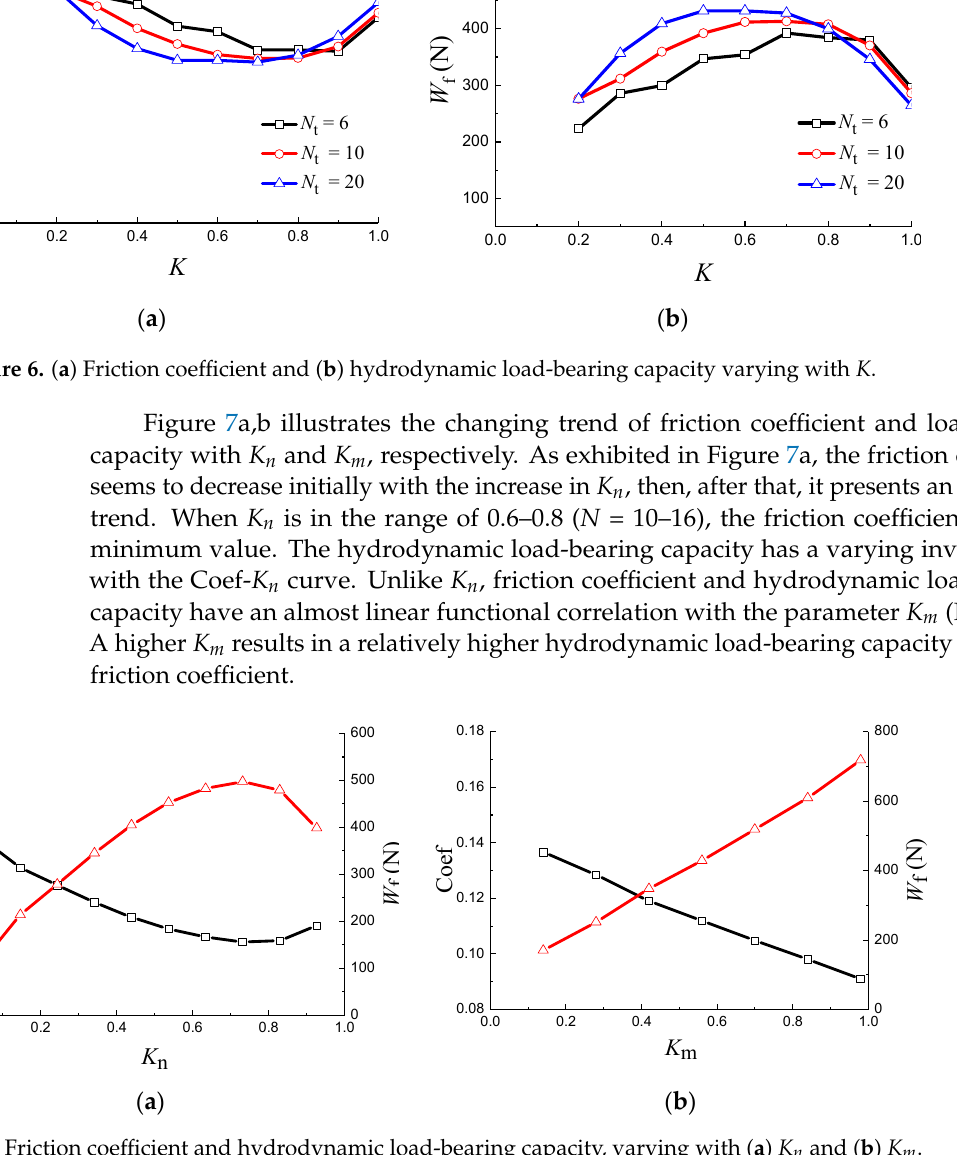
Figure 7. Friction coefficient and hydrodynamic load-bearing capacity, varying with ( a ) K n and ( b ) K m .